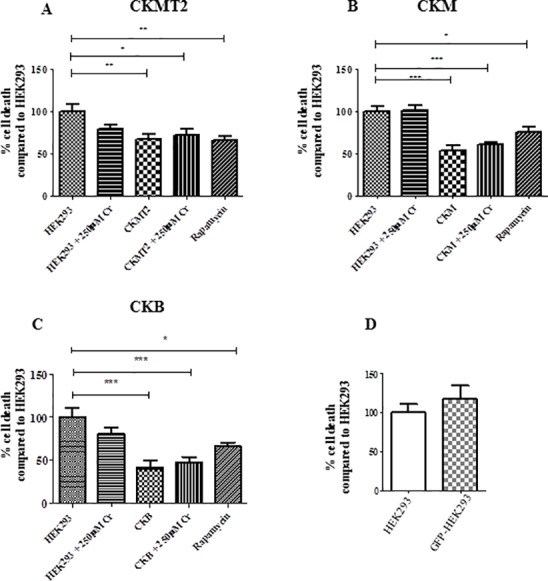
Simulated ischaemia/reperfusion in vitro.HEK293 and stable CK-expressing cells were exposed to 1% O2 for 18h in ischaemic media, followed by 2h re-oxygenation at 18% oxygen, prior to analysis for cell viability by propidium iodide incorporation. A. CKMT2 B. CKM C. CKB cells, all compared to HEK293 in the presence or absence of 250μM creatine monohydrate. Rapamycin (1μM) pre-exposure was used a positive control that preserves cell viability. Data are shown from at least 5 individual experiments and analyzed by One-Way ANOVA, Dunnett’s post-hoc test vs HEK293. ***P<0.001; **P<0.01; *P<0.05. D. GFP-HEK293 control cells were compared to HEK293 and showed lower survival rates (**P<0.01; Student’s t test) in contrast to the CK-stable cells in A-C. D. Control HEK293-GFP cell line showed similar death % to HEK293 (Student’s t test P>0.05) tested during n = 3 independent experiments. Data is mean ± SEM.